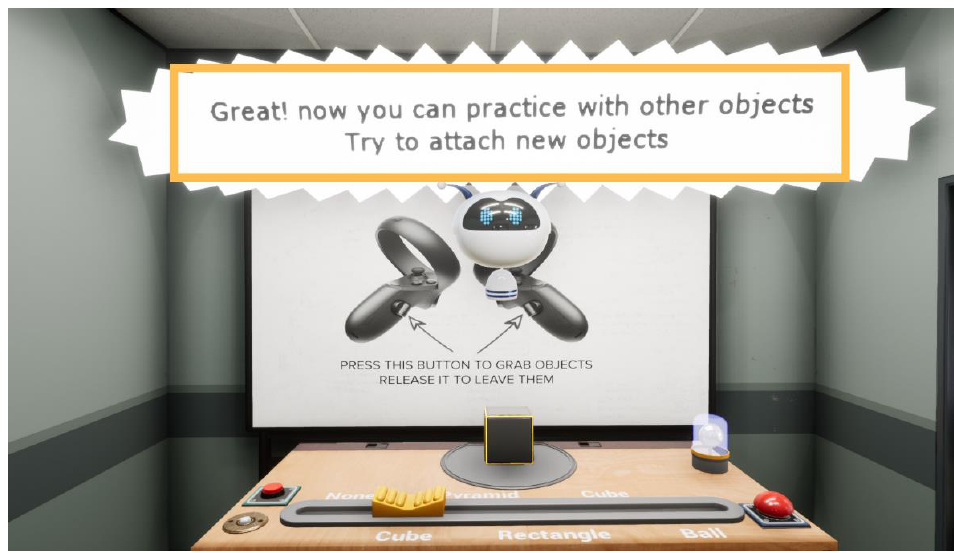
Figure 6. A capture of the iVR tutorial where the informal communication style that uses the assistant robot can be seen.